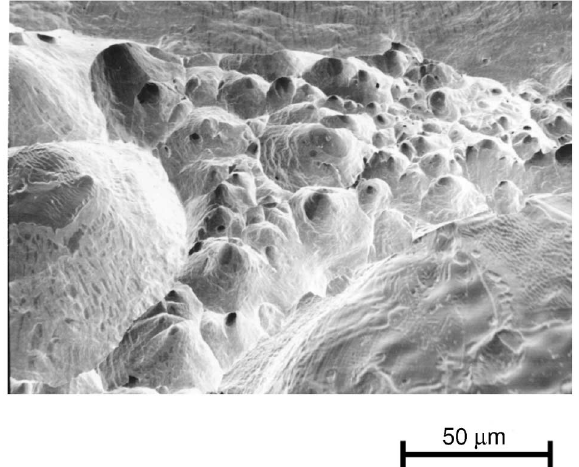
FIG. 13. SEM image of the fracture surface of the silver brazed joint showing a very ductile